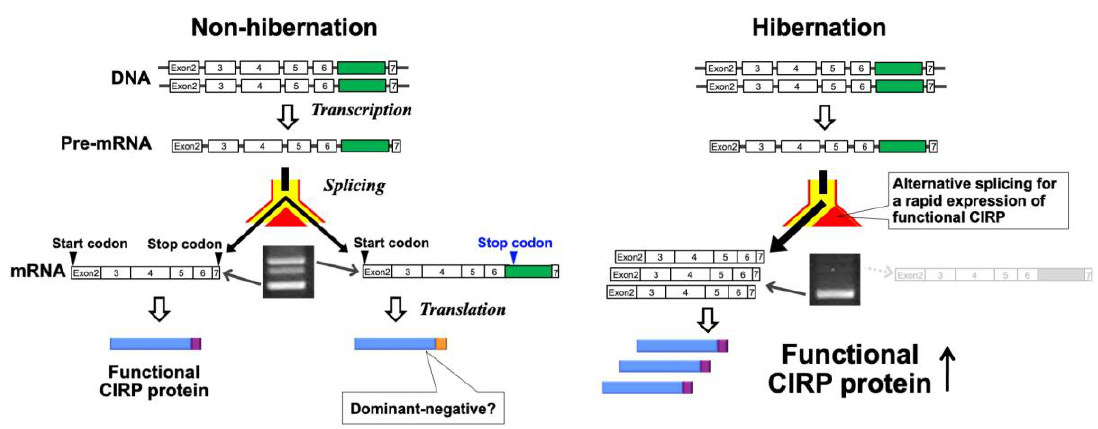
Figure 2. Post-transcriptional regulation of expression of the CIRP gene by alternative splicing in non-hibernating euthermic and hibernating hypothermic hamsters. The figure was modified from our published article [14,127].